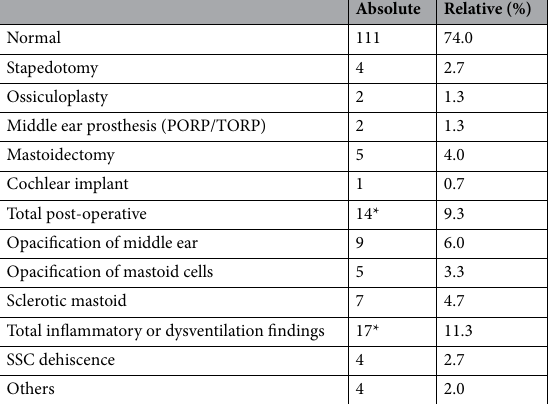
Table 1. Radiological findings from 150 temporal bone computed tomography scans (*Indicates overlapping of different procedures as well as inflammatory or dysventilation related changes in some sets). PORP Partial ossicular reconstruction prosthesis, TORP Total ossicular reconstruction prosthesis, SSC Superior semicircular canal.